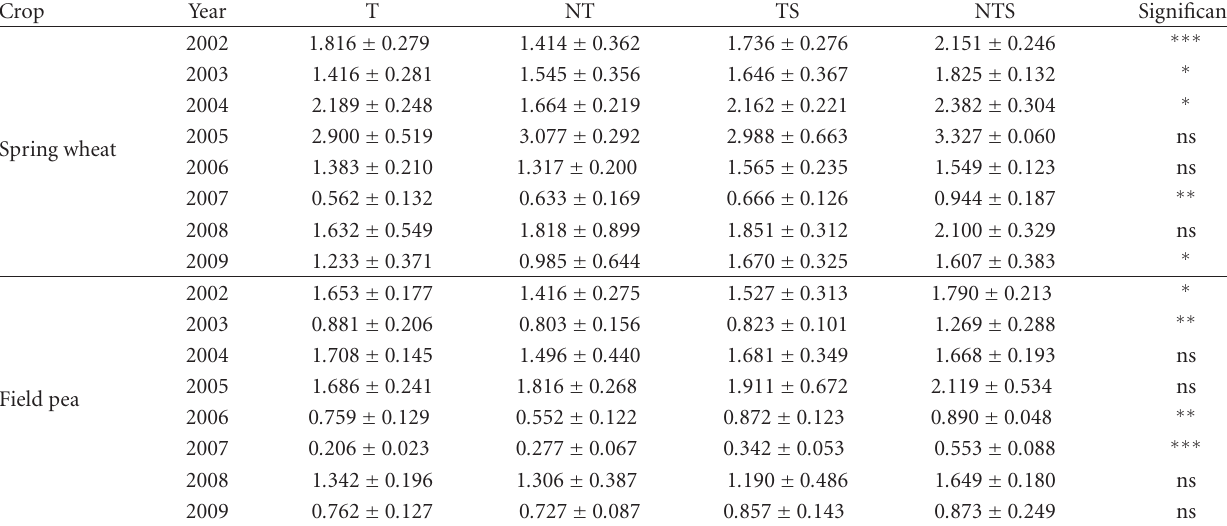
Table 7: Grain yield under di ff erent treatments (tha − 1